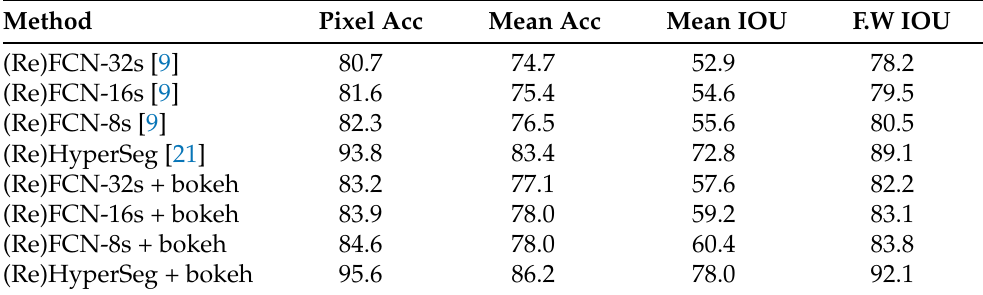
Table 4. The segmentation performance of three variants of FCN on the PASCAL VOC 2012 validation set, “(Re) FCN-XXs + bokeh” means the bokeh module is added to “(Re)FCN-XXs”.